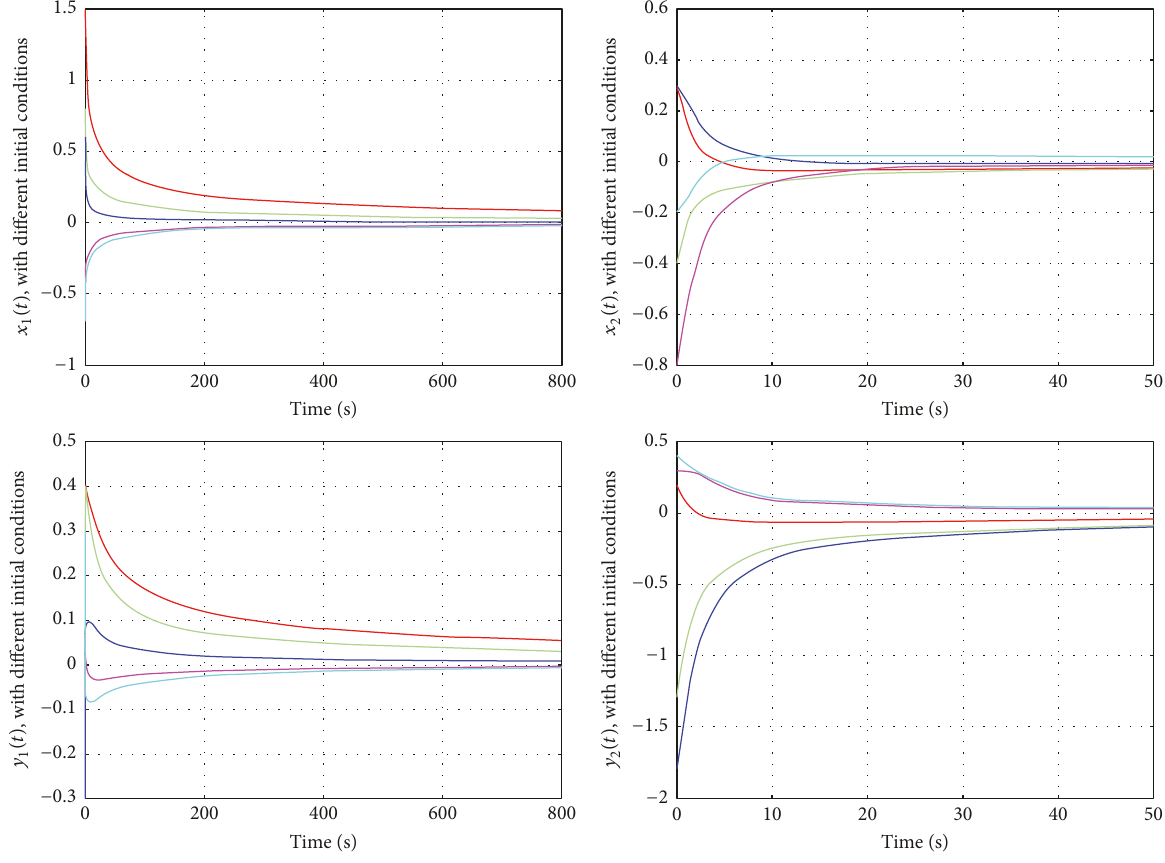
Figure 1: State trajectories of BAM neural network (42) with 𝛼 = 0.2; 𝛽 = 0.6 under different initial